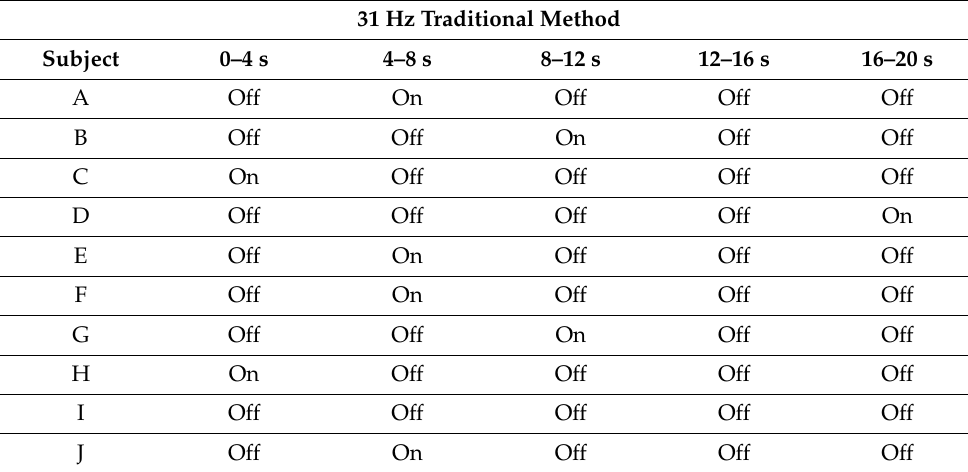
Table 6. The traditional method has five signals in the 31 Hz brainwave signal.